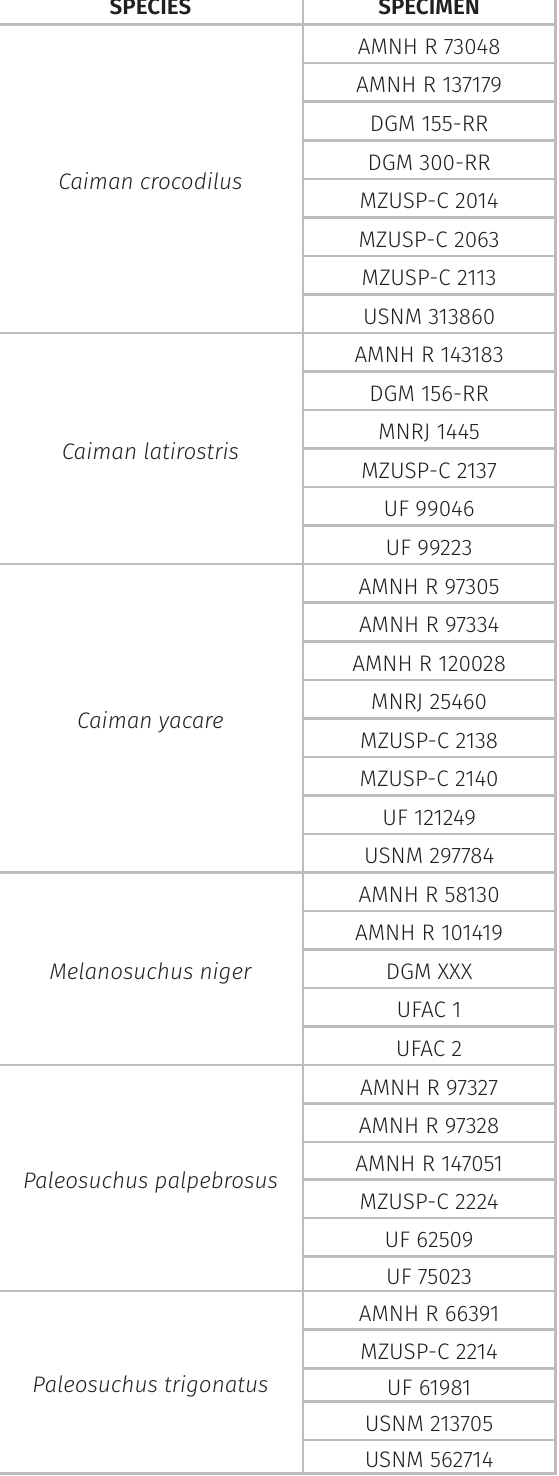
Table II. Studied extant Caimaninae species and